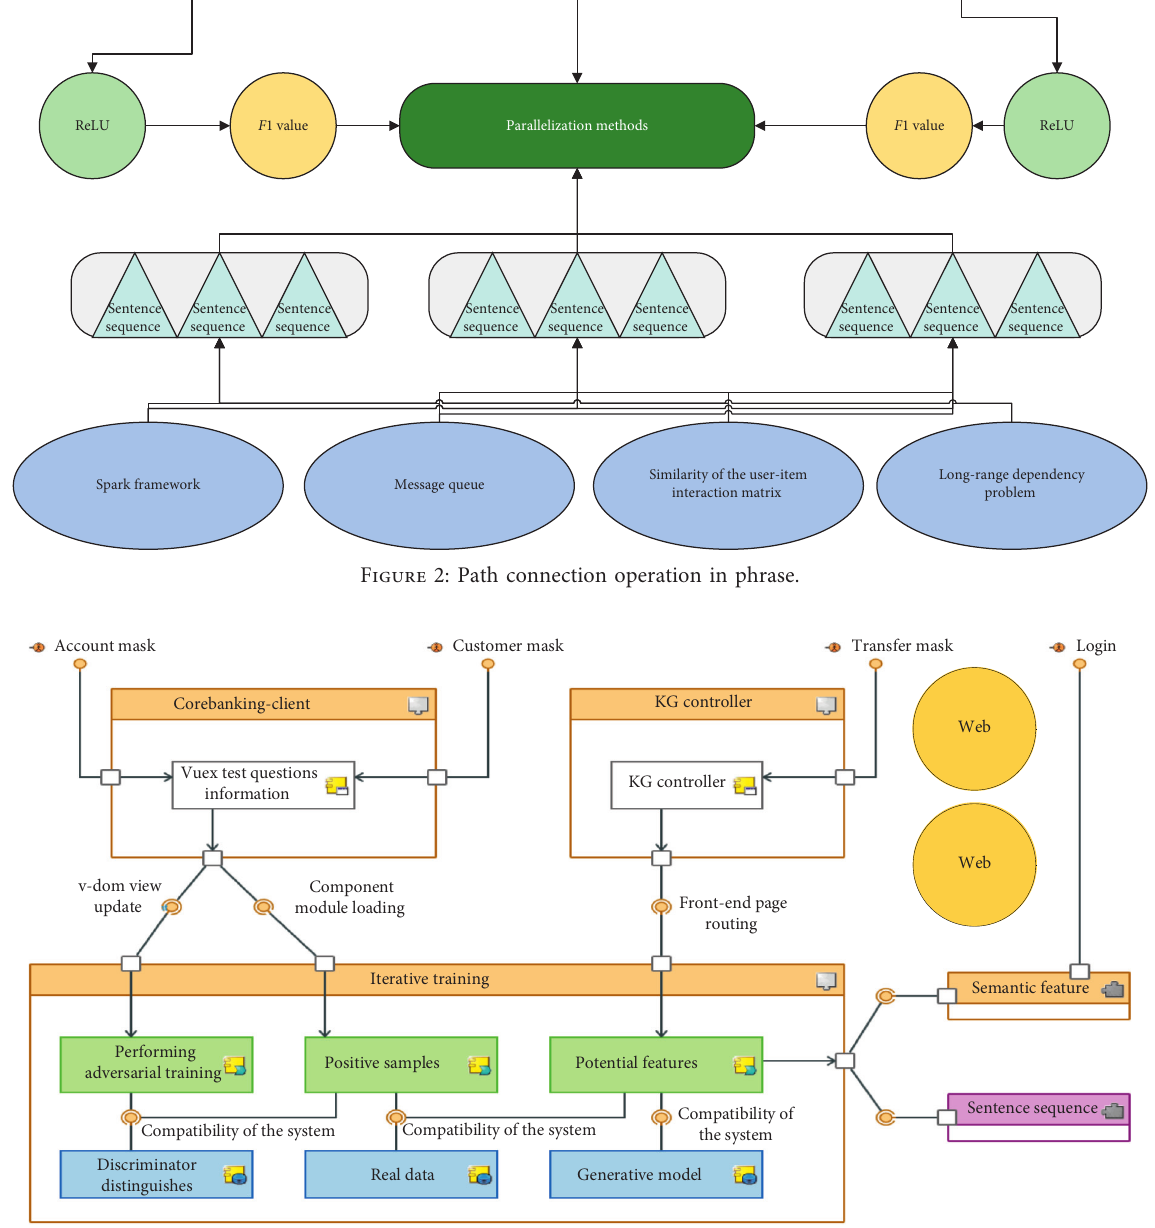
Figure 3: Vue logic structure diagram.